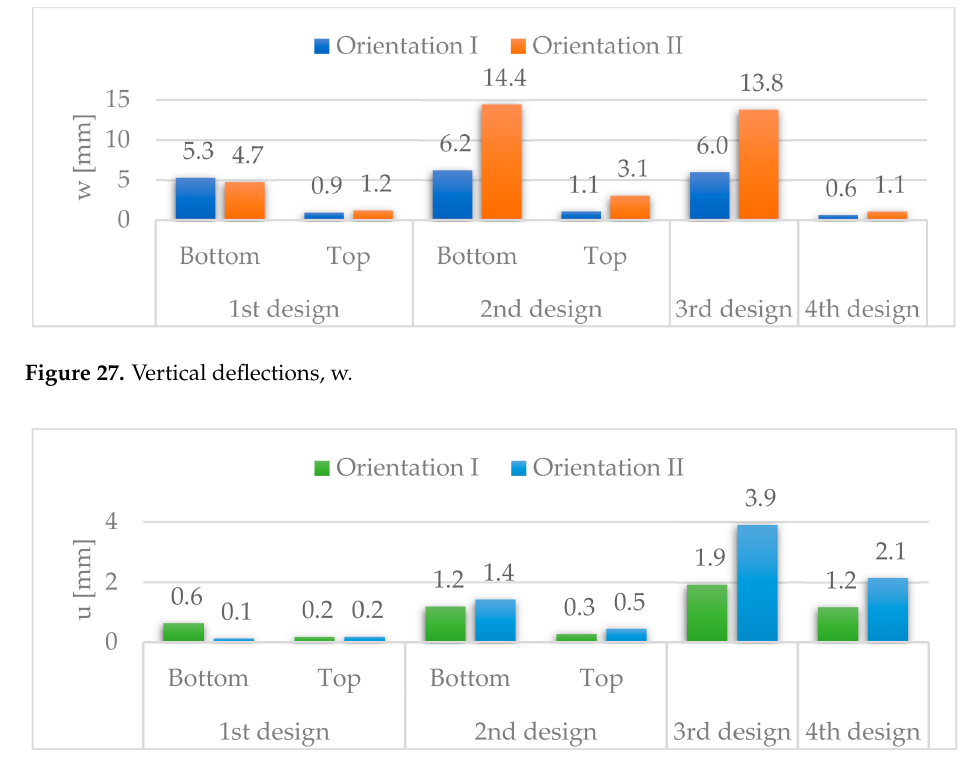
Figure 28. Longitudinal deflections,